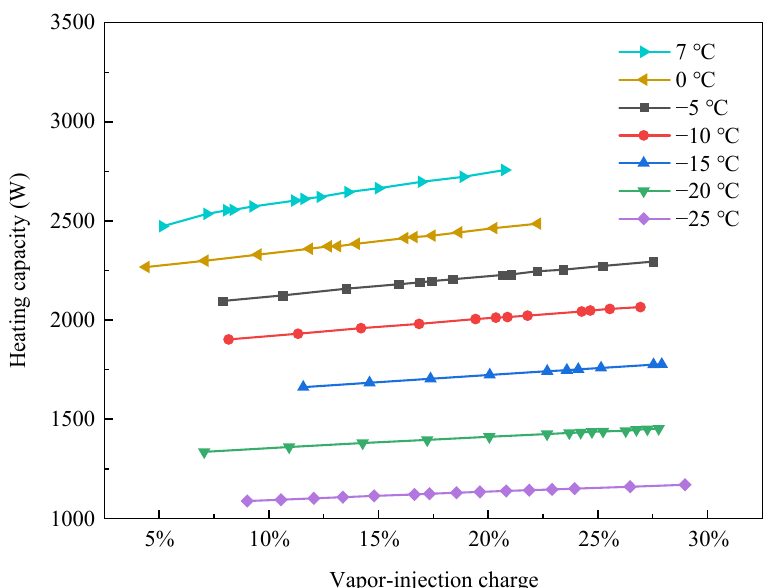
Figure 6. Influence of vapor-injection charge on the heating capacity of the HHE–ASHPD system.